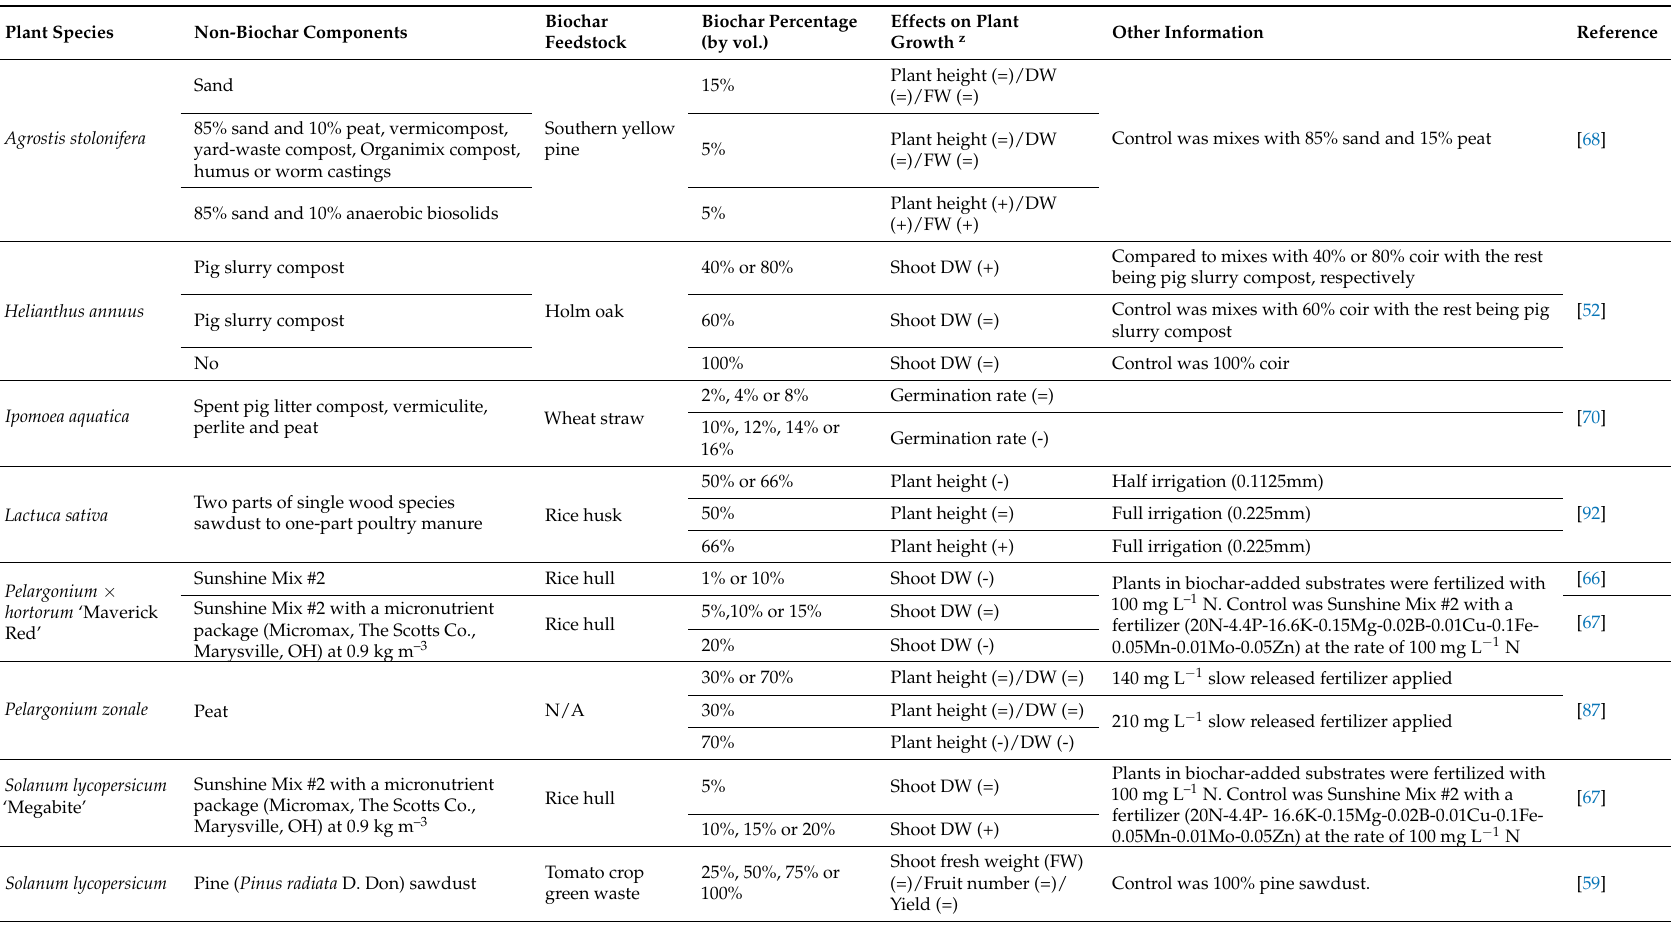
Table 5. Other studies testing the effects of biochar mixed with other substrate components on container-grown